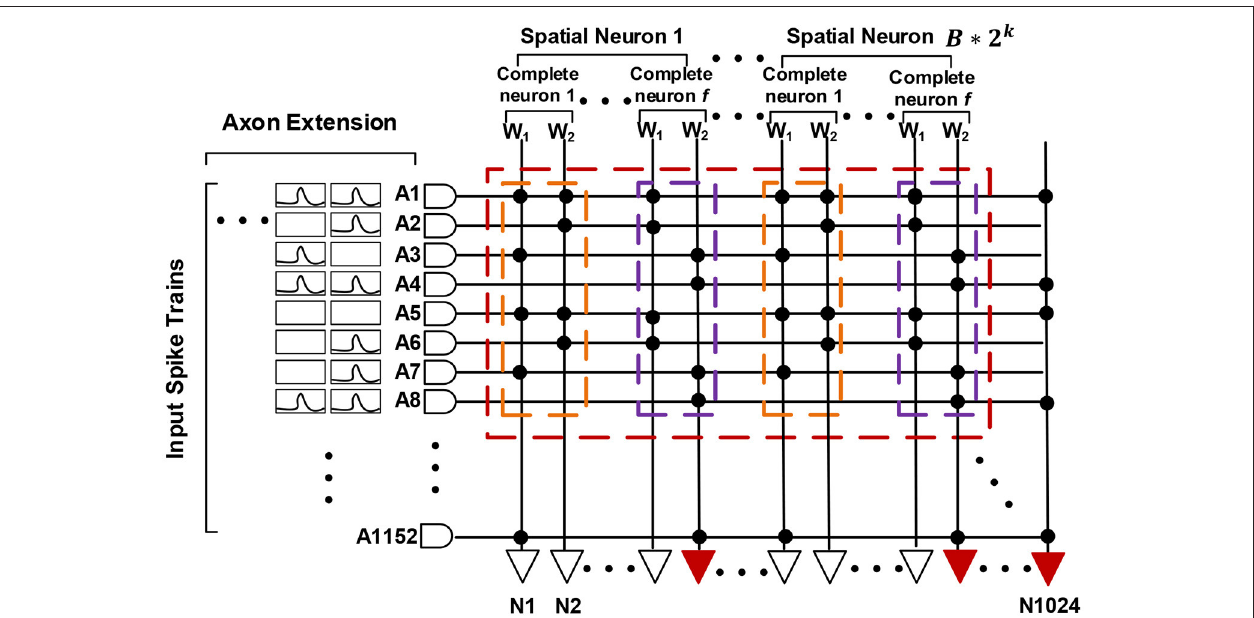
FIGURE 8 | Spatial mapping for spiking neural networks (SNNs) with scatter-and-gather conversion. An artificial neural network (ANN) neuron is replaced by B * 2 k spatial SNN neurons, and each spatial neuron comprises f complete neurons with ternary-valued